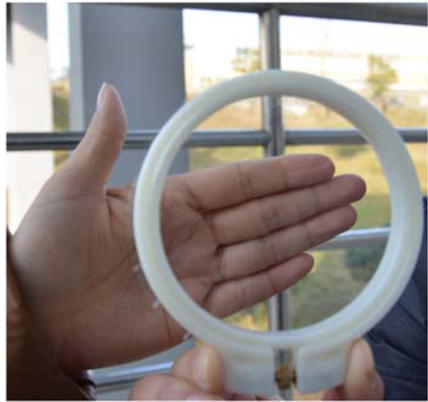
Figure 2: Photograph of polymer FEP film with the diameter of 90